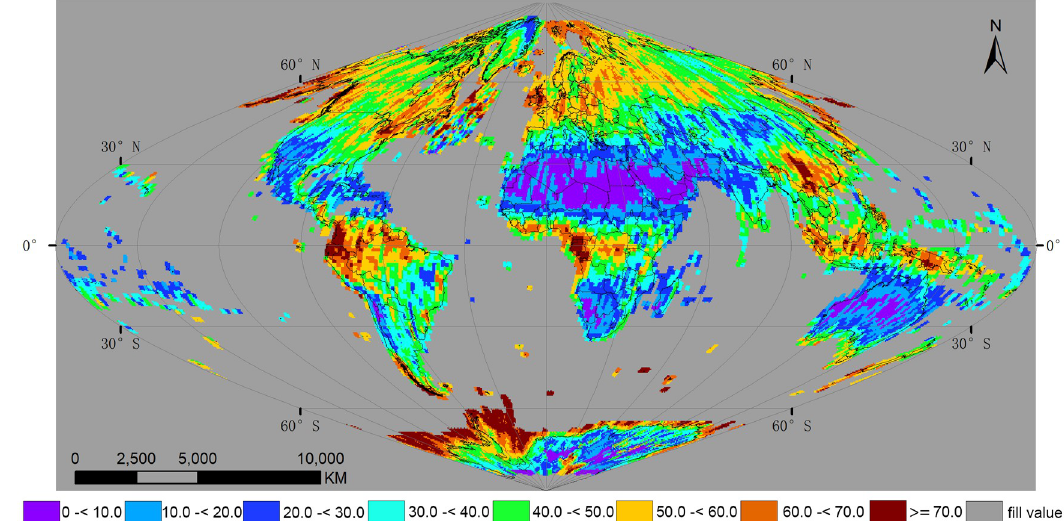
Figure 6. Average percent cloud cover of Landsat‐8 satellite observations over each land grid point in 2018. The results were examined on a global grid defined by an equal area sinusoidal projection, composed of 7201 × 3601 grid points, with a spacing of 0.05°.